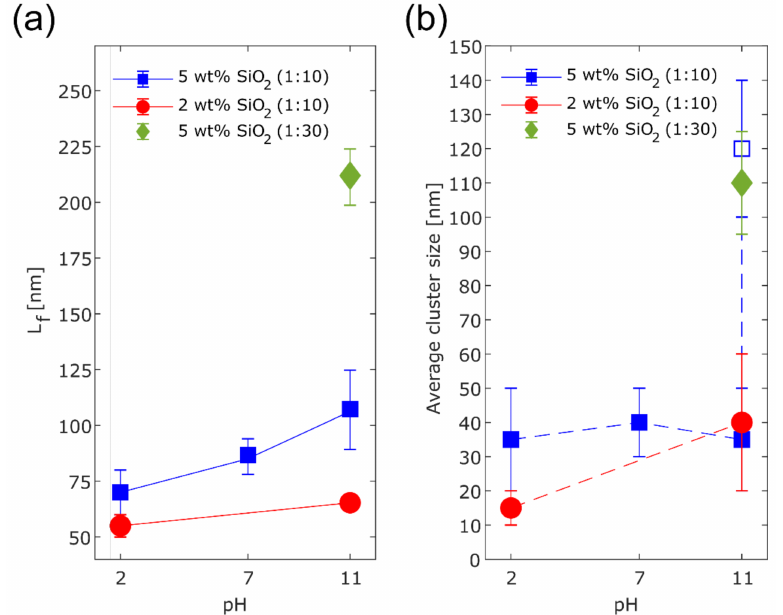
Figure 3. Changes in the dispersion quality with variations in pH, filler content, and amount of SCA (shown as the ratio of APTES:DGEBA in parentheses in the legend) used in the synthesis. The ( a ) L f and ( b ) average cluster sizes are shown for composites prepared with 2 and 5 wt.% SiO 2 ( (cid:108) and (cid:110) respectively) and 1:10 of APTES:DGEBA at different pH. The (cid:117) indicates the composite prepared at pH 11 with 1:30 APTES:DGEBA and 5 wt.% SiO 2 . In ( b ), the indicates the average size of the (cid:50)